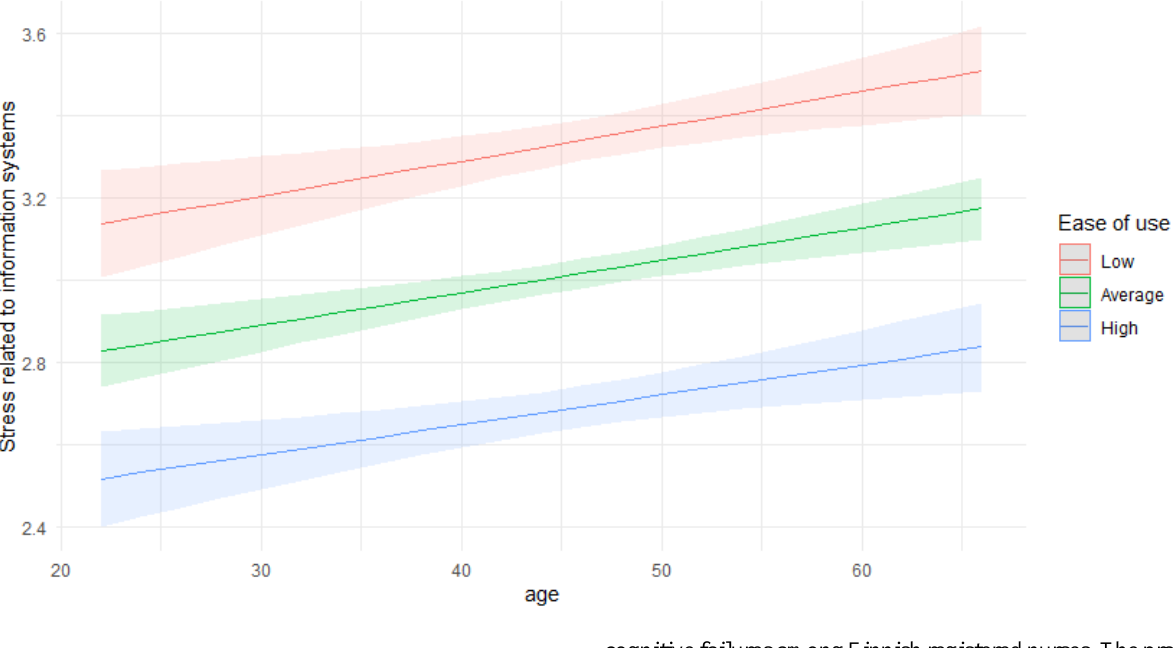
Figure 2. Interaction effect between EHR usability (ease of use) and user’s age for information system–related stress. The association is shown for low (mean − 1 SD), average, and high (mean + 1 SD) levels of ease of use. EHR: electronic health